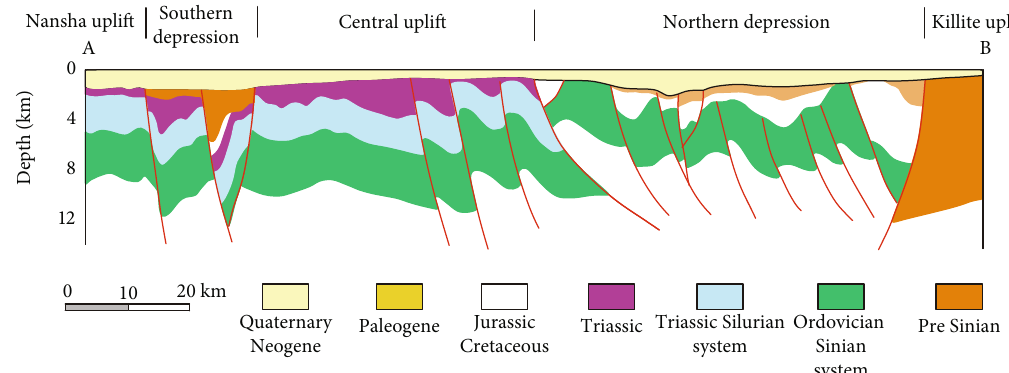
Figure 5: Pro fi le distribution of Triassic in the South Yellow Sea Basin [14].